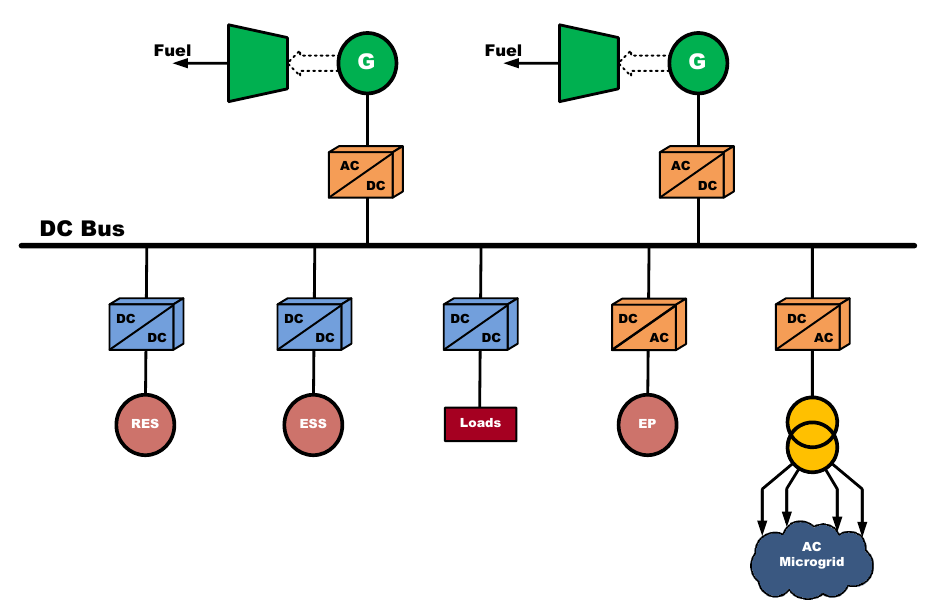
Figure 15. Electric scheme for all Electric Ships.